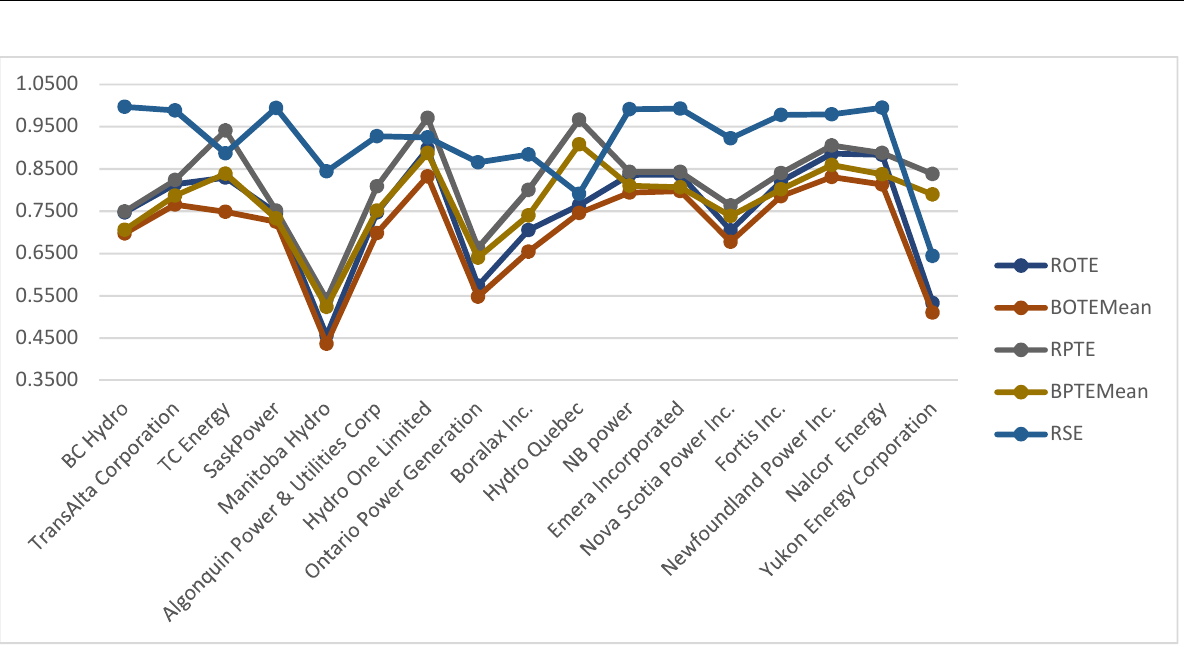
Figure 2. Efficiency scores for the 17 power-generating companies.